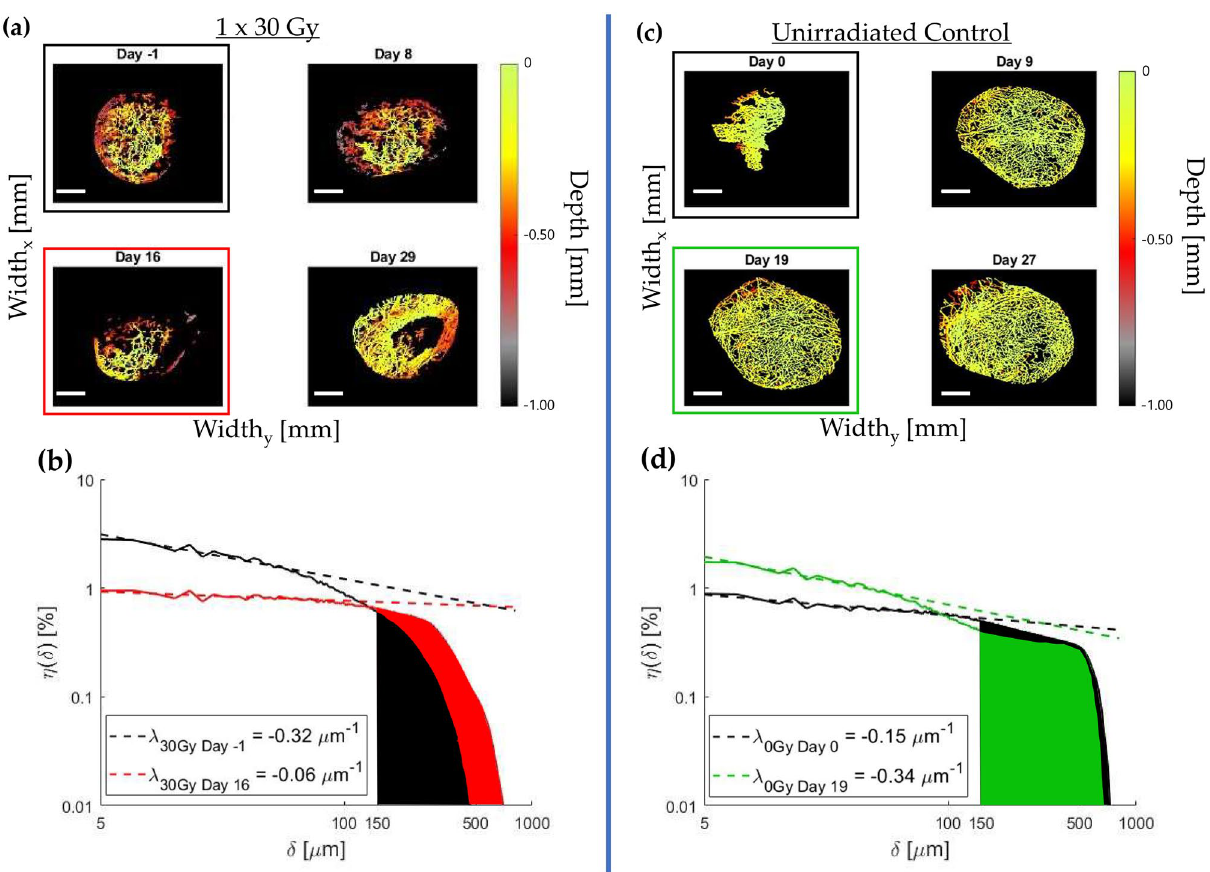
Figure 3. Illustrative changes in vascular architectures for irradiated and un-irradiated tumours, with corresponding DLF 150 and (cid:31) quantification: ( a ) 30 Gy irradiated and ( c ) unirradiated control colour-depth encoded binarized vasculature within the tumour VOI for several timepoints over the course of a month; ( b ) 0 and t 2 3 weeks DNV histograms for both mice, and the two derived and ( d ) show the corresponding t ∼ ∼ − metrics. The slope of the histogram at short distances (defining the convexity index (cid:31) ) generally increased after irradiation at this time (b), while the opposite was seen in unirradiated controls (d). For “avascular” regions as quantified by DLF 150 , the trends were a general initial increase in DLF 150 with dose (b), while it slightly decreased in the absence of irradiation (d). More comprehensive time-dose summary for all animals is presented in Fig. 4. Scale bars are 1